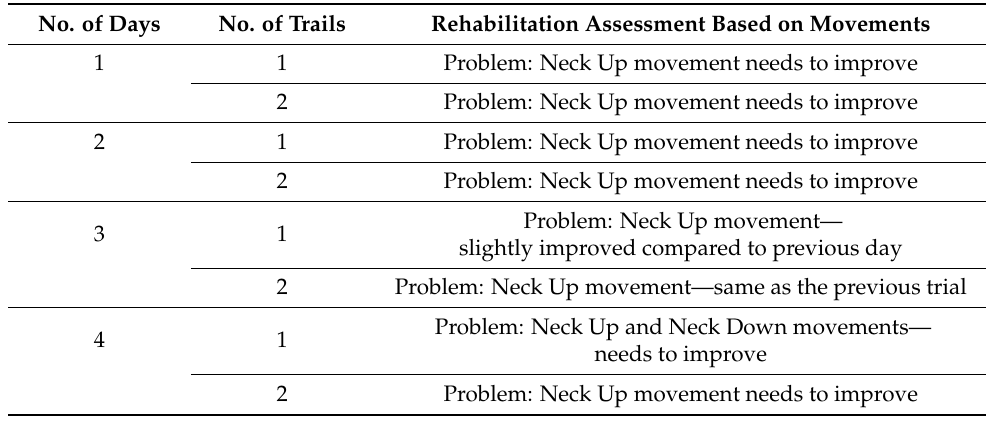
Table 4. Rehabilitation monitoring and assessment—model analysis report. No. of Days No. of